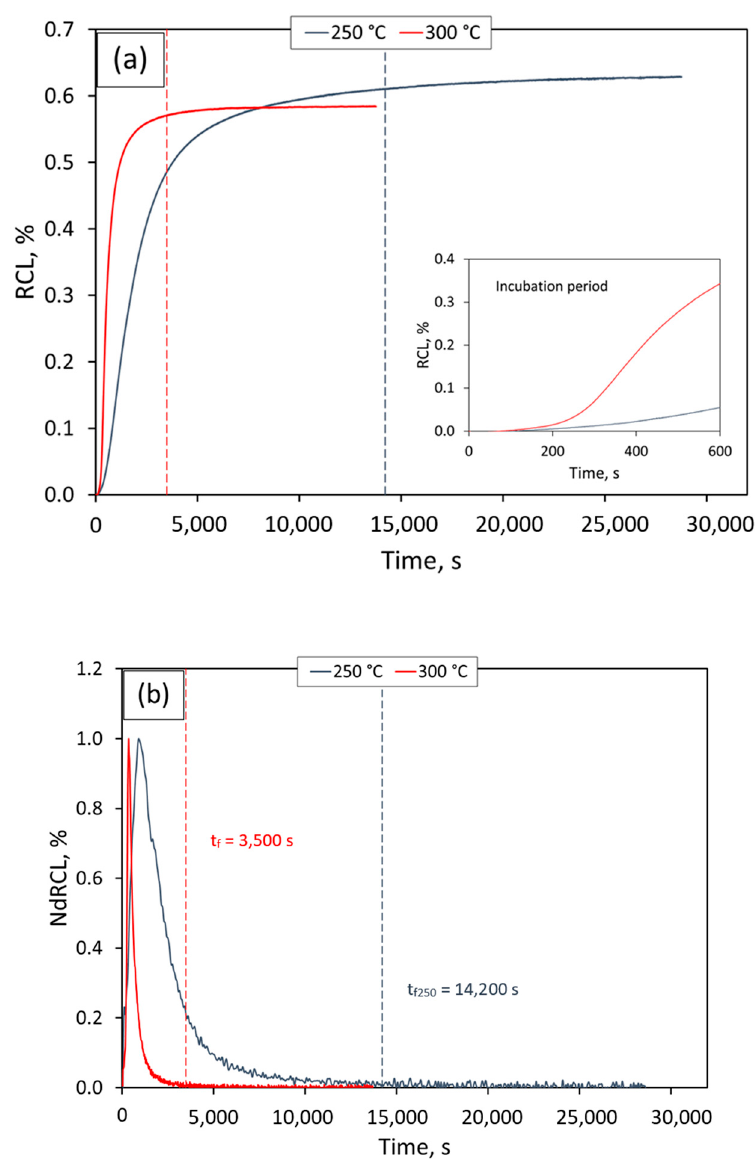
Figure 2. High-resolution dilatometry testing to study the bainitic transformation of the cast steel: ( a ) relative change in length (RCL); ( b ) normalized first derivative of RCL curves (NdRCL).